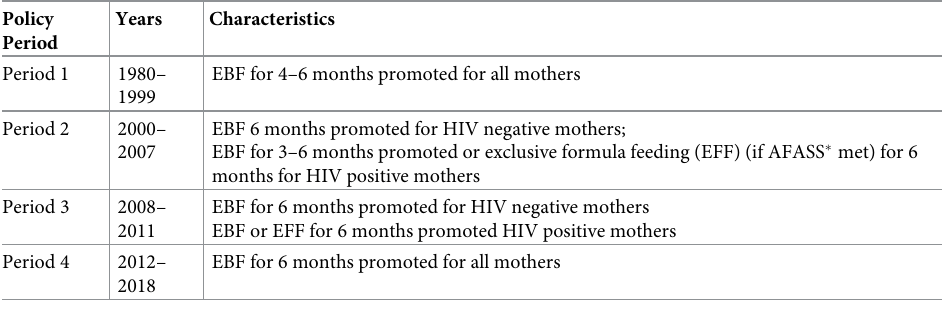
Table 1. Infant feeding policy periods in South